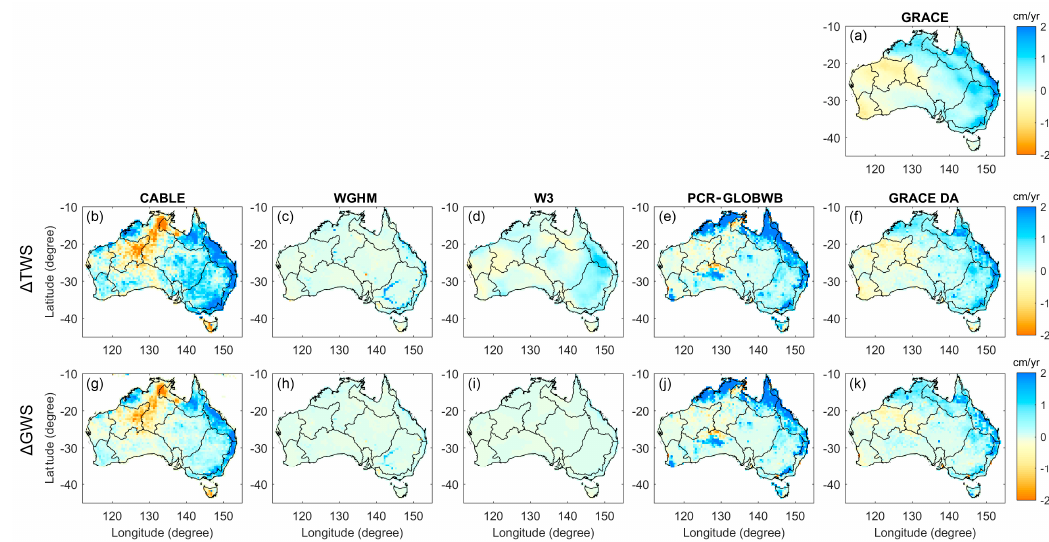
Figure 7. The long-term trend (cm/year) of the Δ TWS (second row) and Δ GWS (third row) estimates from four models (CABLE ( b , g ), WGHM ( c , h ), W3 ( d , i ), PCR-GLOBWB ( e , j )) and the GRACE DA ( f , k ) in Australia. The trend of the GRACE observation is also shown ( a ).